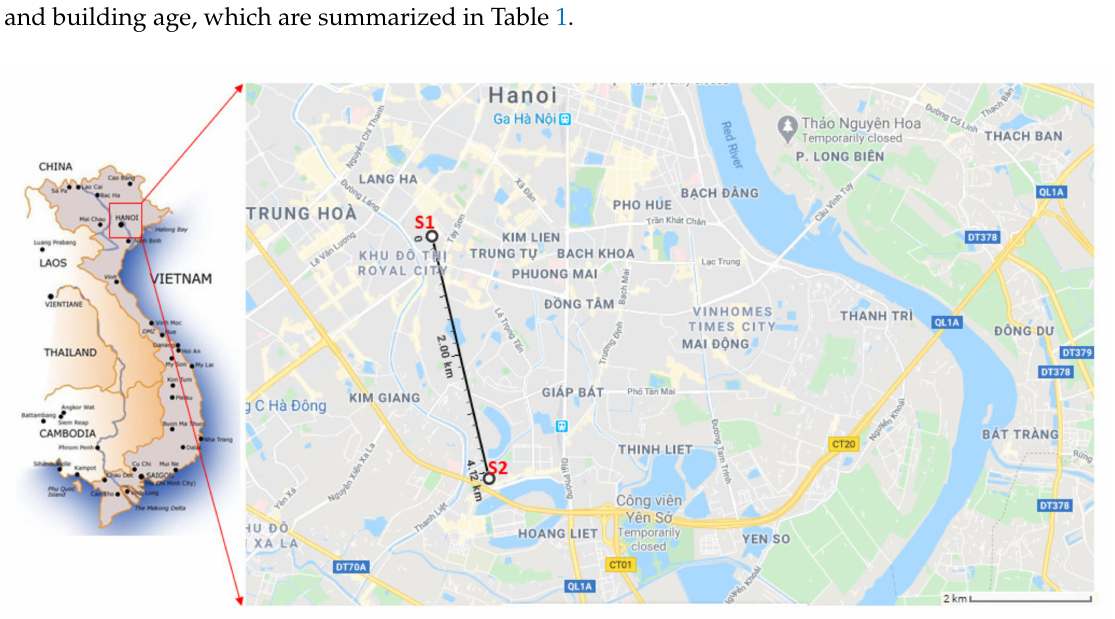
Figure 1. Location of the two examined preschools in Hanoi, S1 = school 1, S2 = school